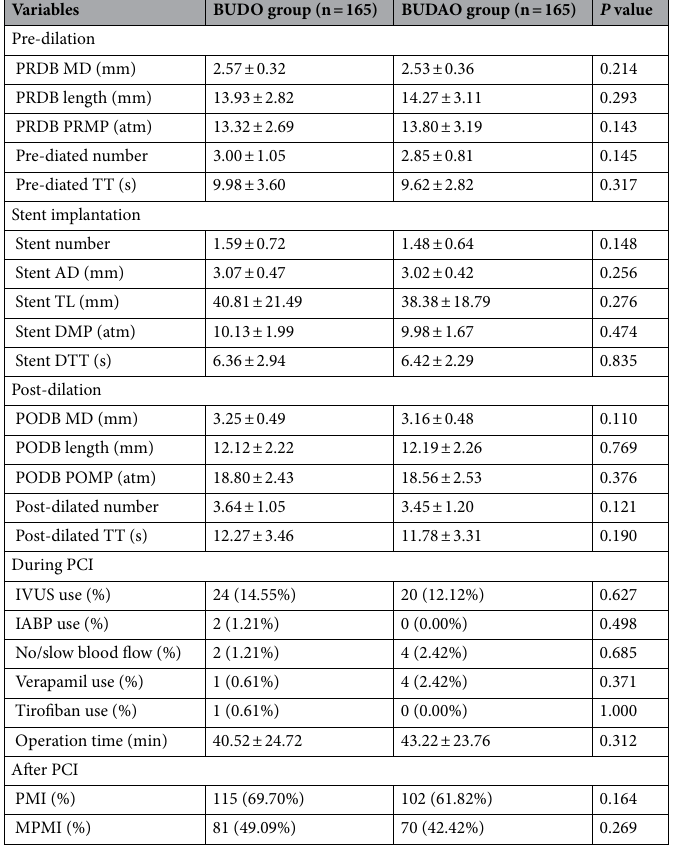
Table 3. PCI procedural data and incidence of PMI in the BUDO and BUDAO groups. Data were expressed as n (%), mean ± SD. PMI Procedural myocardial injury; PRDB Pre-dilated balloon; MD Maximal